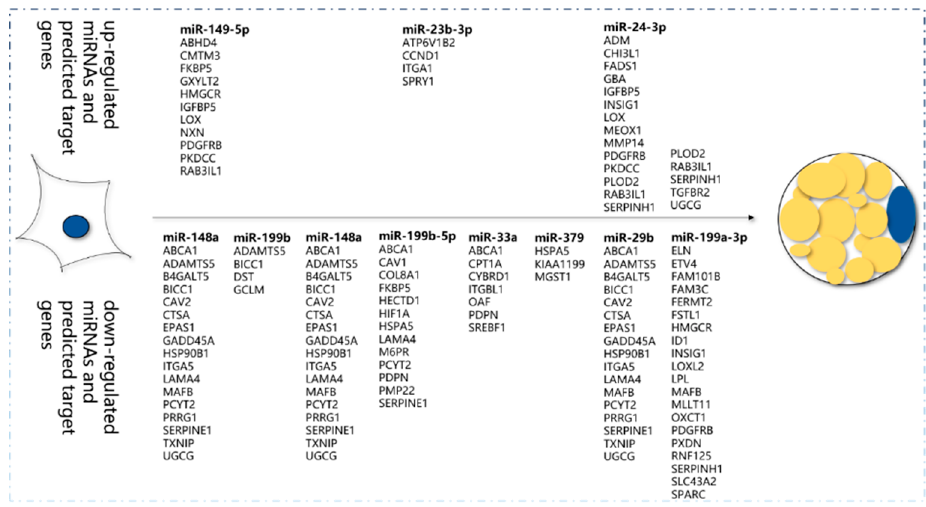
Figure 5. Candidate miRNAs and relevant target genes in bovine preadipocytes and differentiated adipocytes.